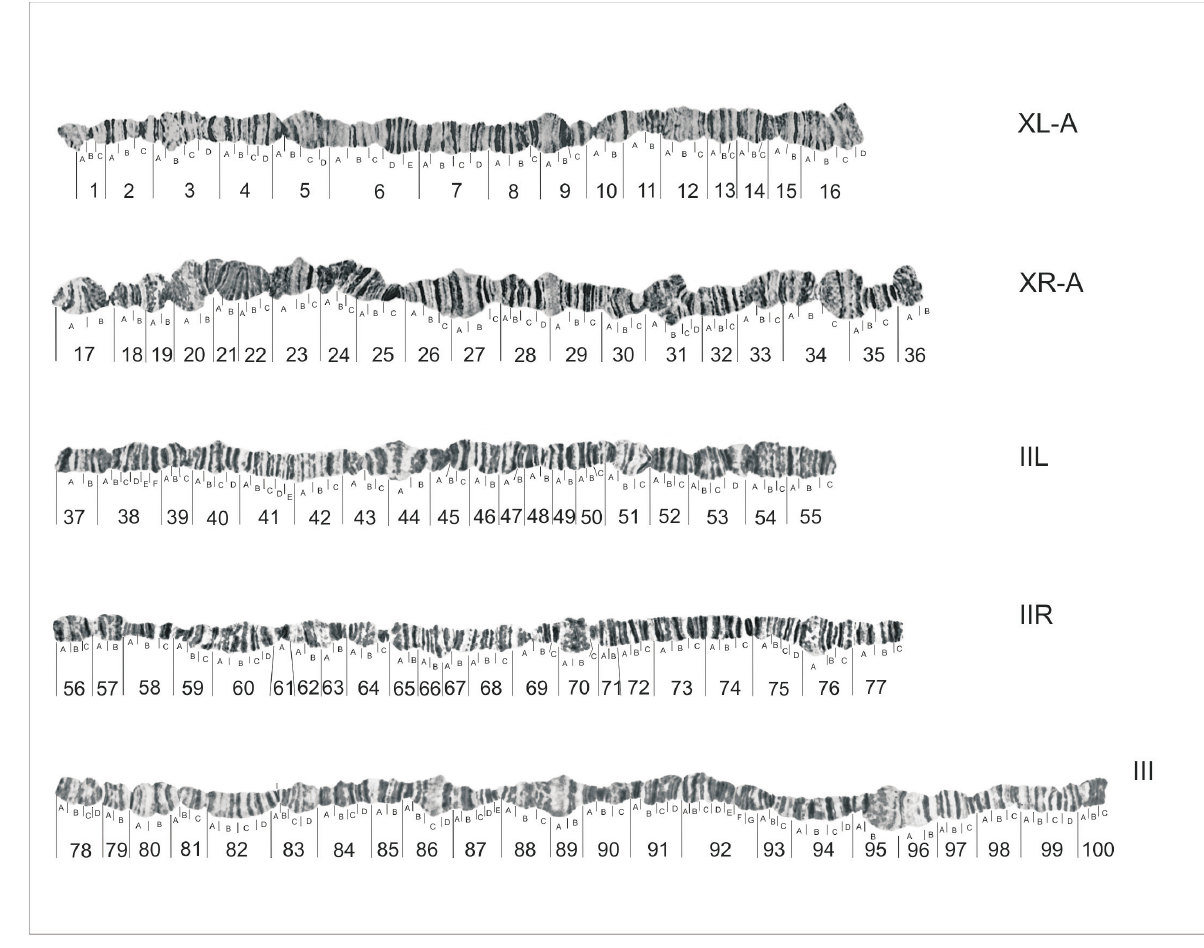
Figure S1 - Reference photomap of Drosophila willistoni